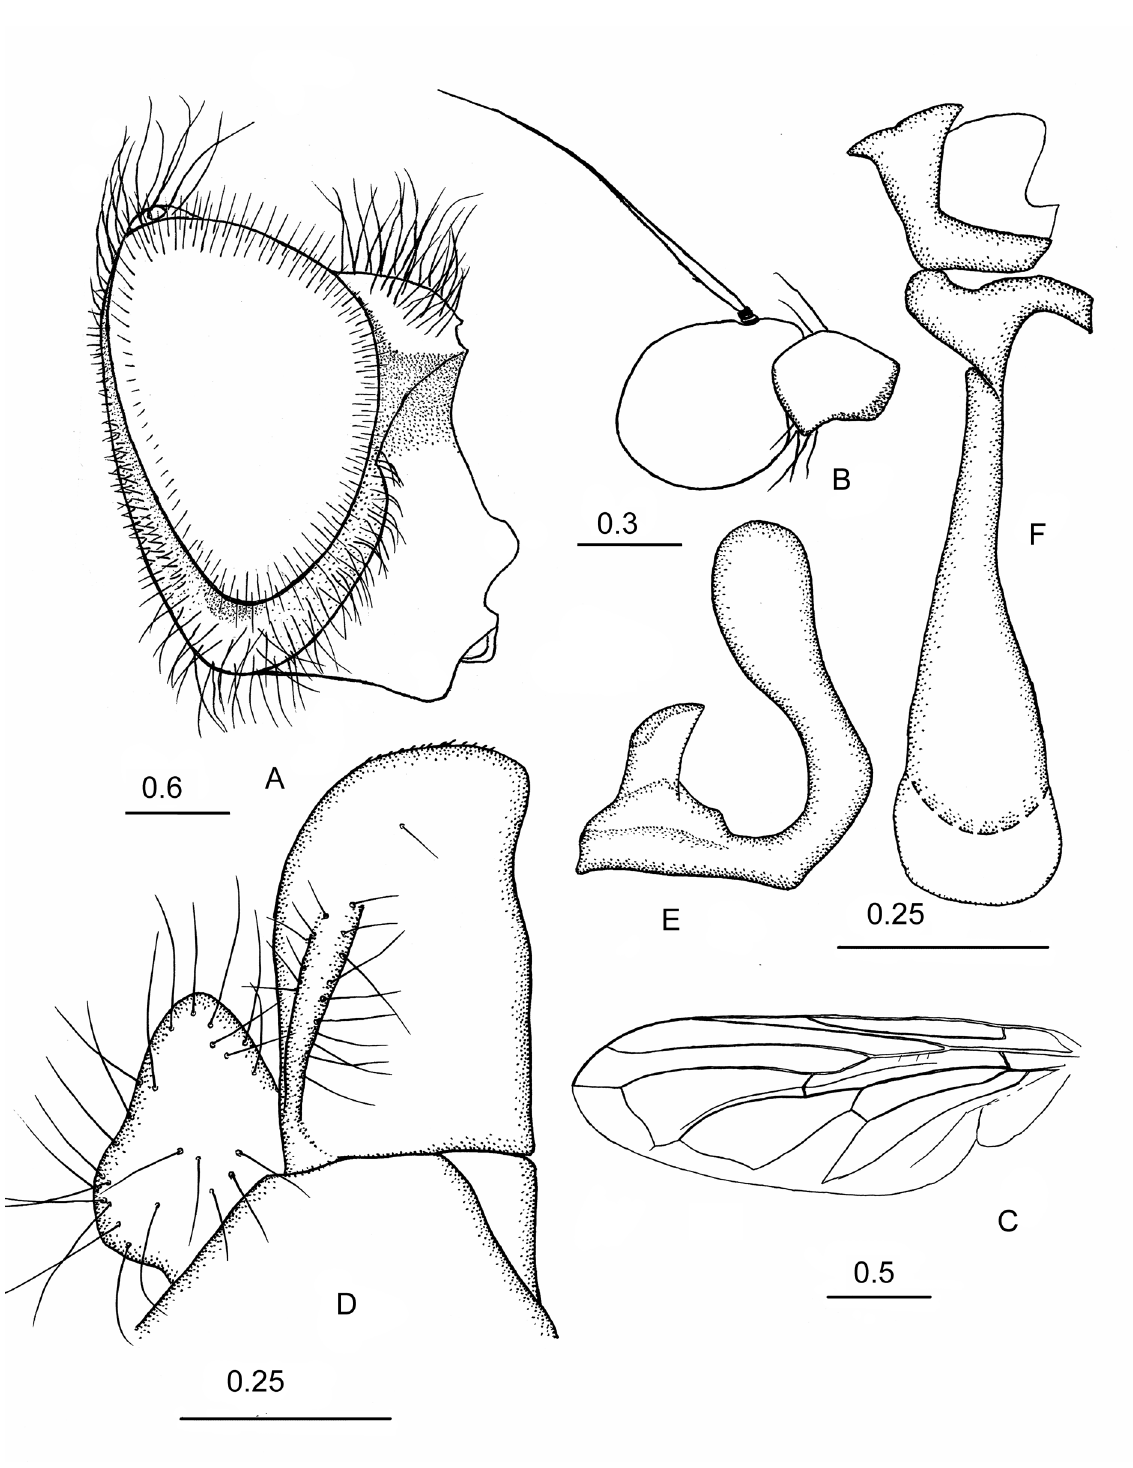
Fig. 52. Cheilosia ( Cheilosia ) pilivena sp. nov., holotype, ♂ (CNC). A . Head, lateral view. B . Antenna, lateral view of pedicel and basoflagellomere. C . Wing. D . Surstylus and gonocercus, lateral view. E . Superior lobe of hypandrium, lateral view. F . Aedeagus and aedeagal apodeme, lateral view. Scale bars indicated in